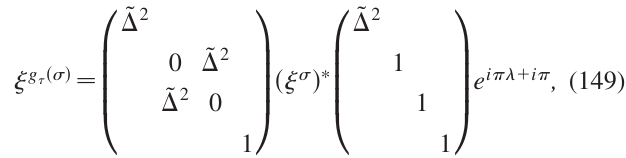
FIG. 9. Configurations (cid:10) ¼ ð (cid:10) position of the leftmost two quasiholes, (cid:10) of the third quasihole relative to the first two. Top (left to right): þ þ , þ 0 , and þ (cid:1) . Bottom (left to right): (cid:1) (cid:1) , (cid:1) 0 , and (cid:1) þ